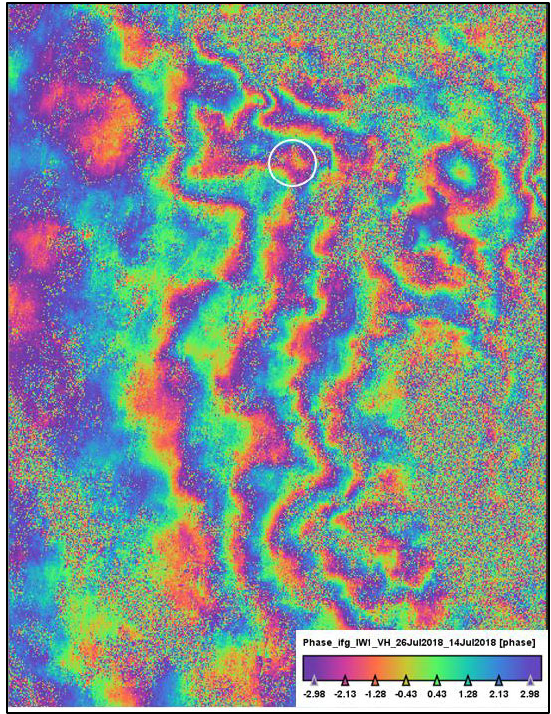
Figure 7 Zoomed view of high deformed Region of India has been deformed due to the water logging in the area.